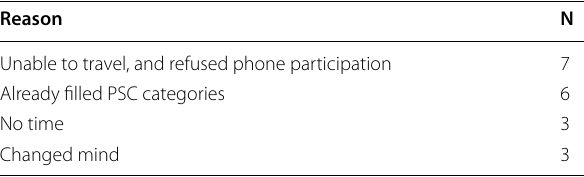
Table 6 Reasons why 19 participants who were screened